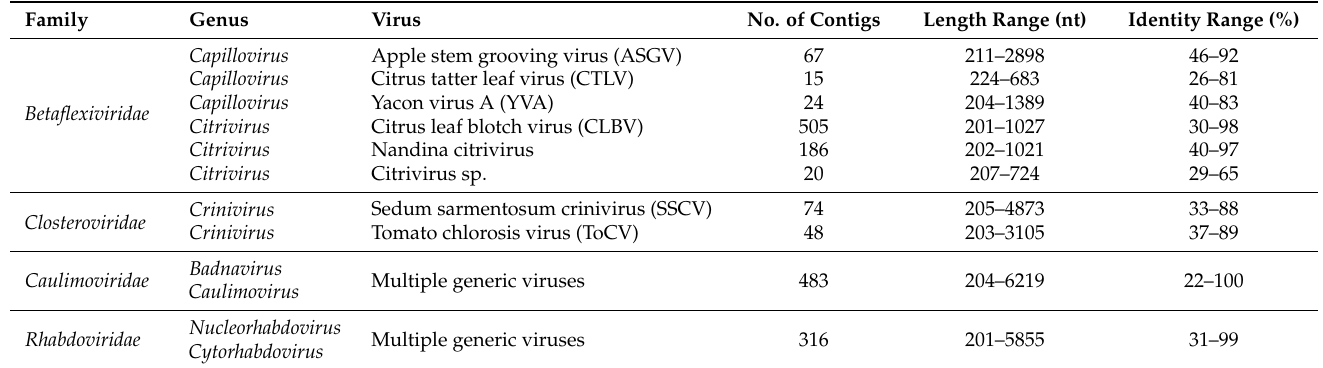
Table 1. Statistics for rRNA-depleted totRNA sequencing output including the number, length range, and identities of viral contigs annotated by BLASTx